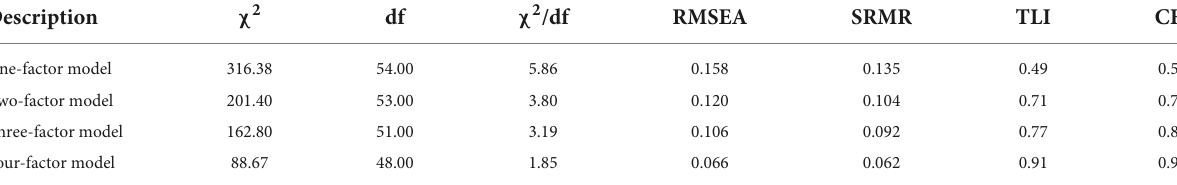
TABLE 1 Confirmatory factor analysis.